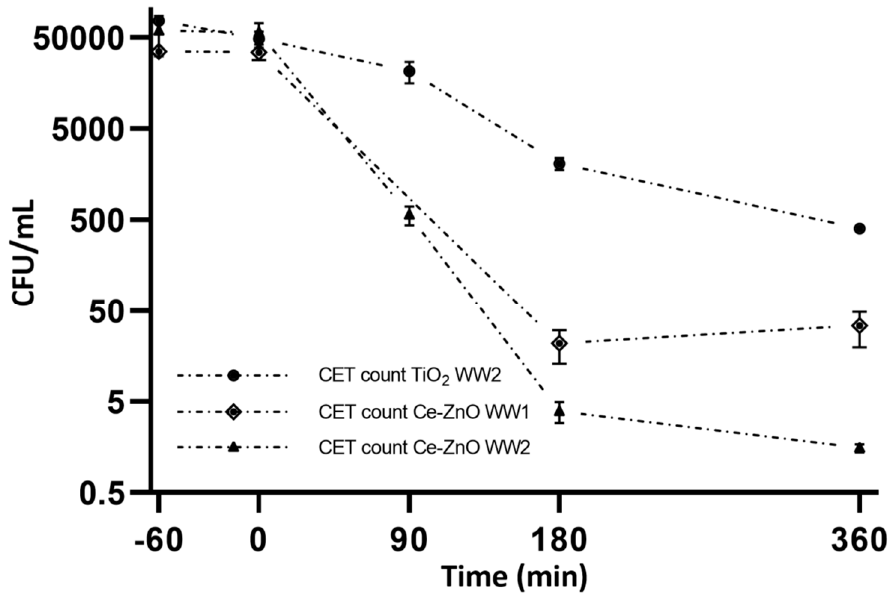
Figure 8. Inactivation of P. aeruginosa . Conditions: 750 mL of WW and 380 cm 2 photocatalyst coated discs with 36 W UVA.